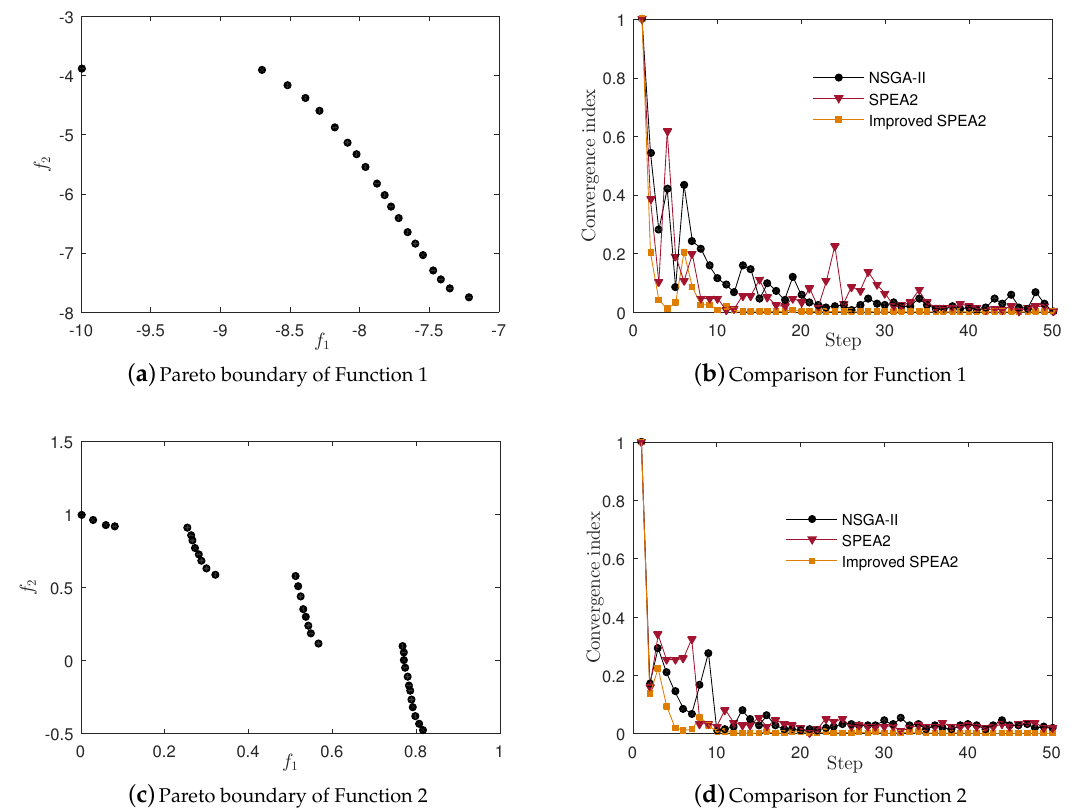
Figure 3. Pareto boundary of two test functions and comparison of convergence results of different